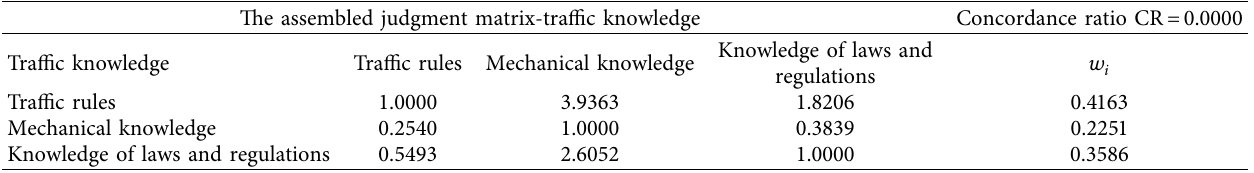
Table 3: Discrimination matrix of traffic knowledge secondary indicators and weight.